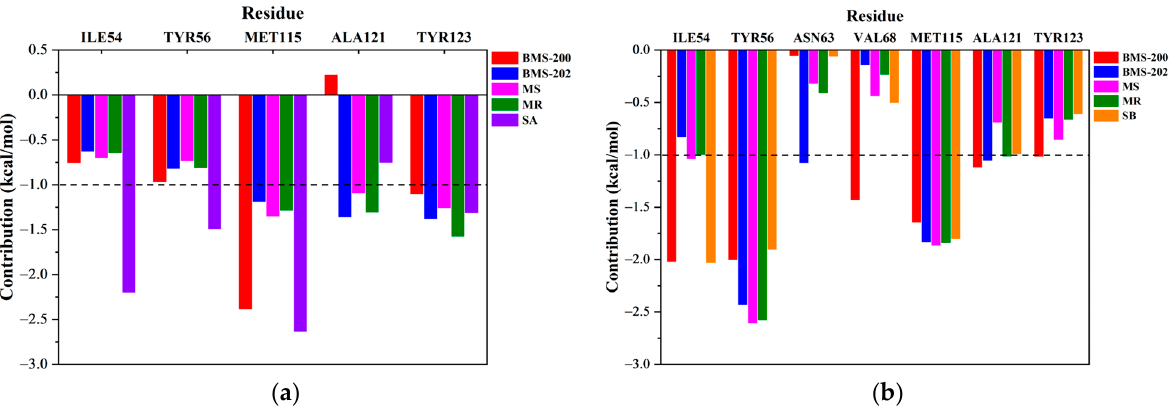
Figure 5. The energy contribution of the residues from ( a ) A PD-L1 and ( b ) B PD-L1 in all systems (all residues identified to be key residues in any systems are shown).